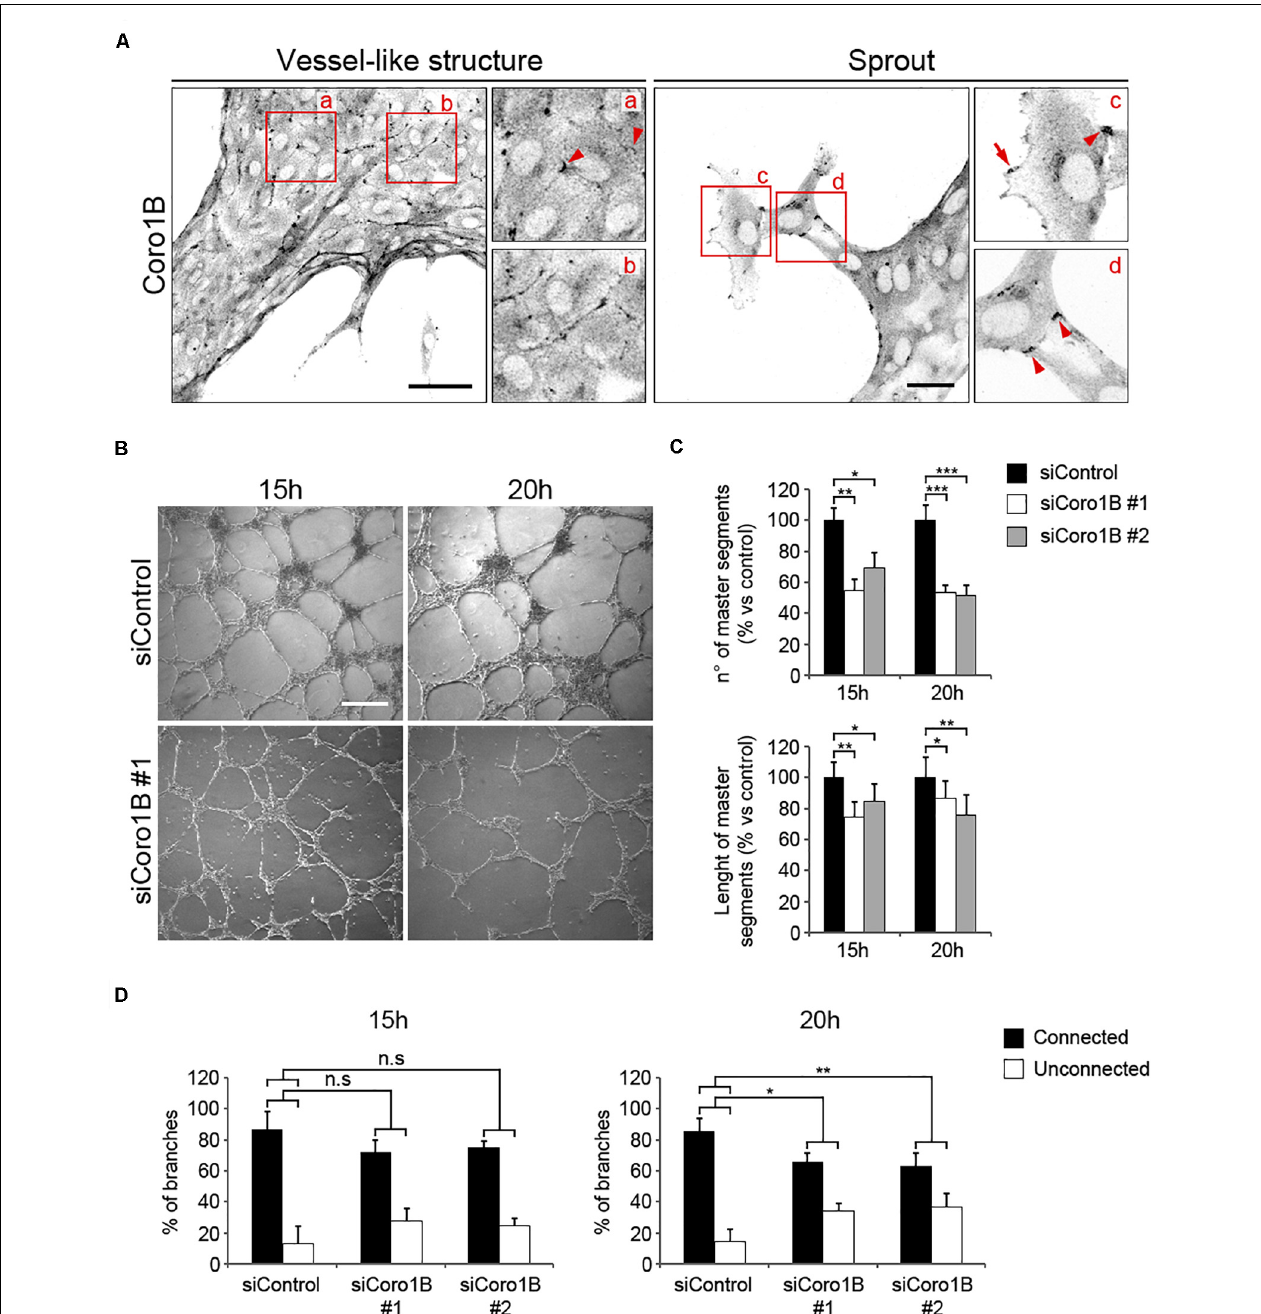
FIGURE 6 | Coro1B is required for proper endothelial network assembly in matrigel. (A) HUVECs cultured on matrigel for 20 h and immunostained for Coro1B. Scale bar = 50 µ m (left) and 25 µ m (right). Arrowheads point to Coro1B localization at JAIL-like structures and arrow indicates Coro1B localization at classical lamellipodium. (B) Representative phase-contrast images of tube networks of control and Coro1B-depleted HUVECs at indicated time points after seeding. Scale bar = 200 µ m. Quantitative analysis of (C) the number and length of master segments and (D) connected and unconnected tube networks of control and Coro1B-depleted HUVECs. Values are normalized to control. Data represent mean ± SD of three independent experiments. * P < 0.05, ** P < 0.01, *** P < 0.001. ns; not significant.